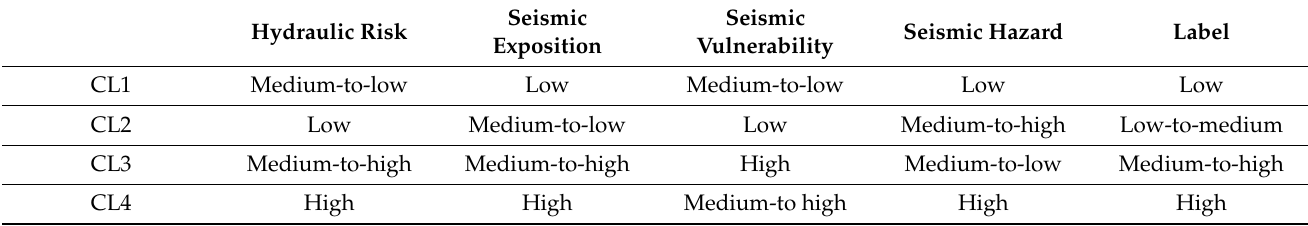
Table 6. Overall risk quantification for each cluster of